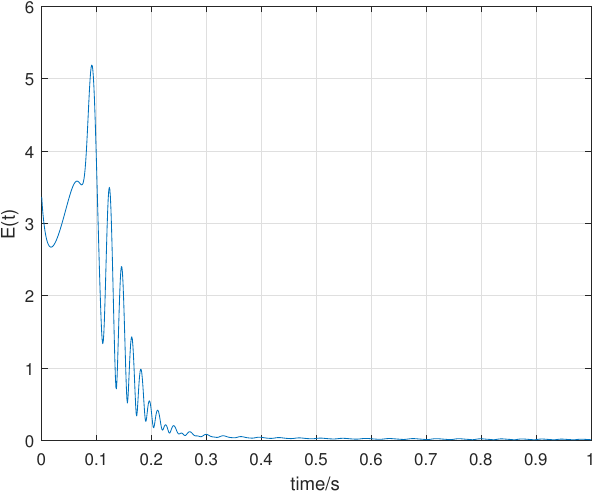
Figure 5. Trajectories of total synchronization errors E ( t ) for the complex networks (70) and (73) with eight fractional order nodes with time